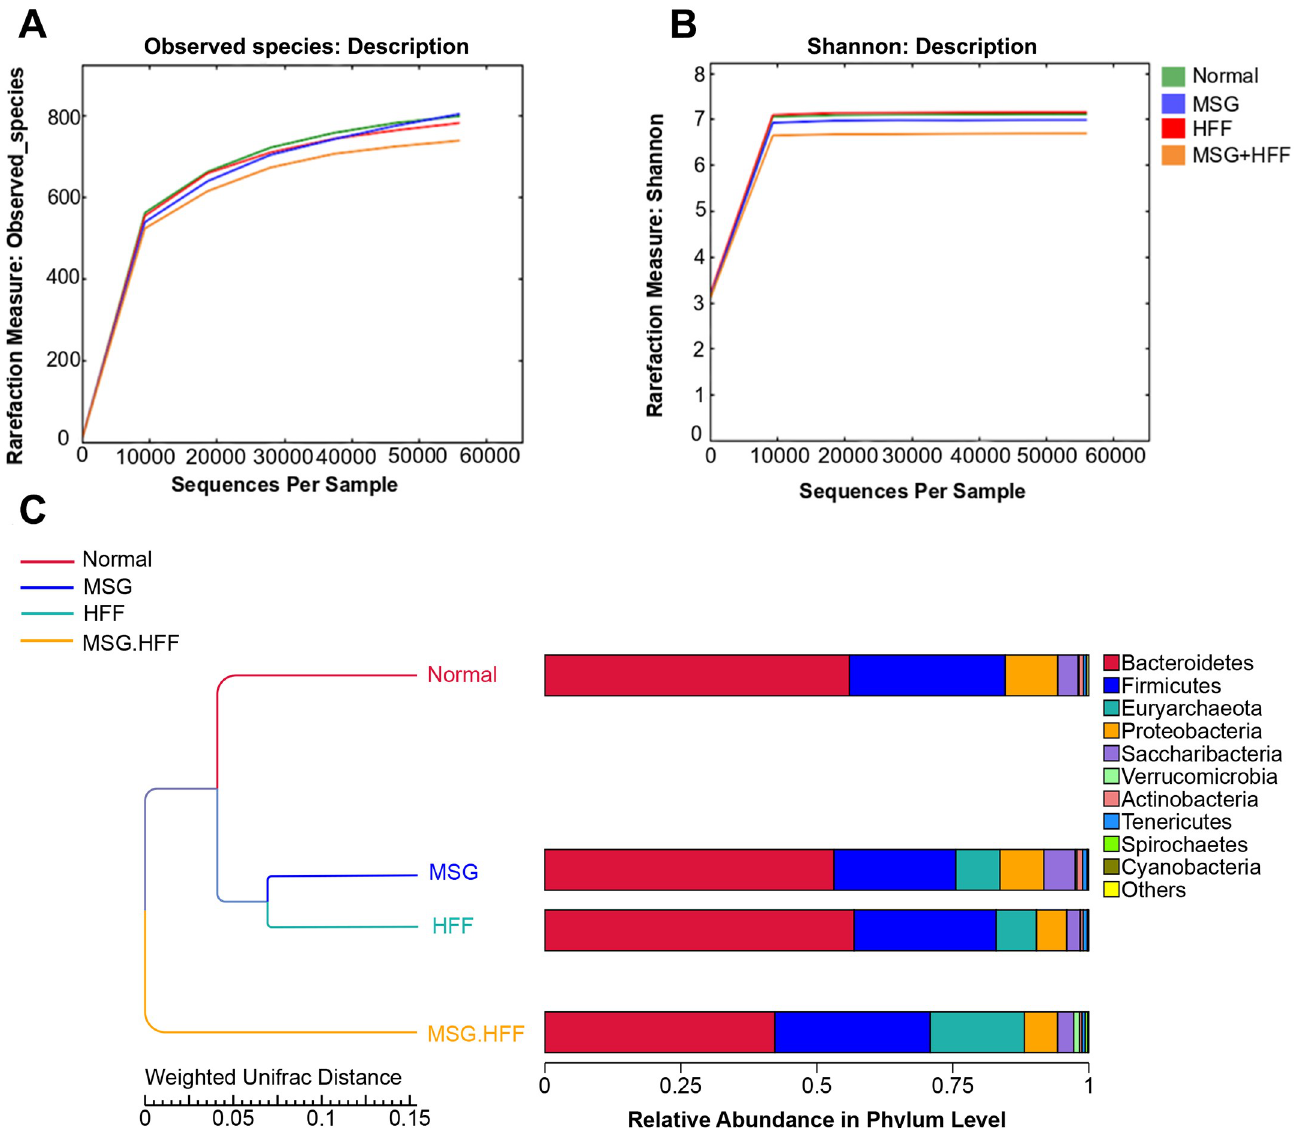
Fig 4. Alpha diversity of the sequence reads from DNA extracted from hamster feces for each group. (A) rarefaction analysis of the observed taxa and (B) the Shannon index. (C) Beta diversity, UPMGA clustering trees-weighted Unifrac distance. The results of clustering using two distance matrixes were combined with the overall percentages of relative abundance among all samples at phylum